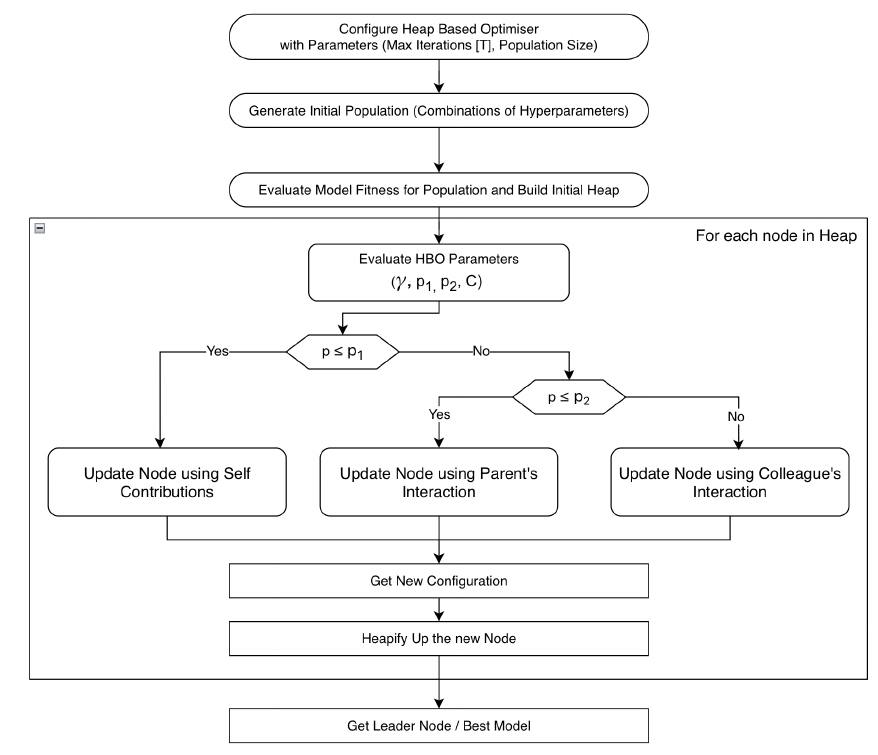
Figure 3. Flowchart of HBO-algorithm for tuning hyperparameters of LSTM